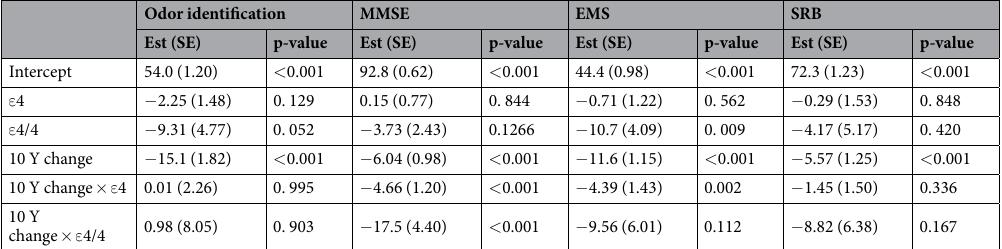
Table 3. Parameter estimates from mixed models of olfactory and non-olfactory cognitive outcomes for old participants, adjusted for age, sex, education, and previous testing experience (one vs. two